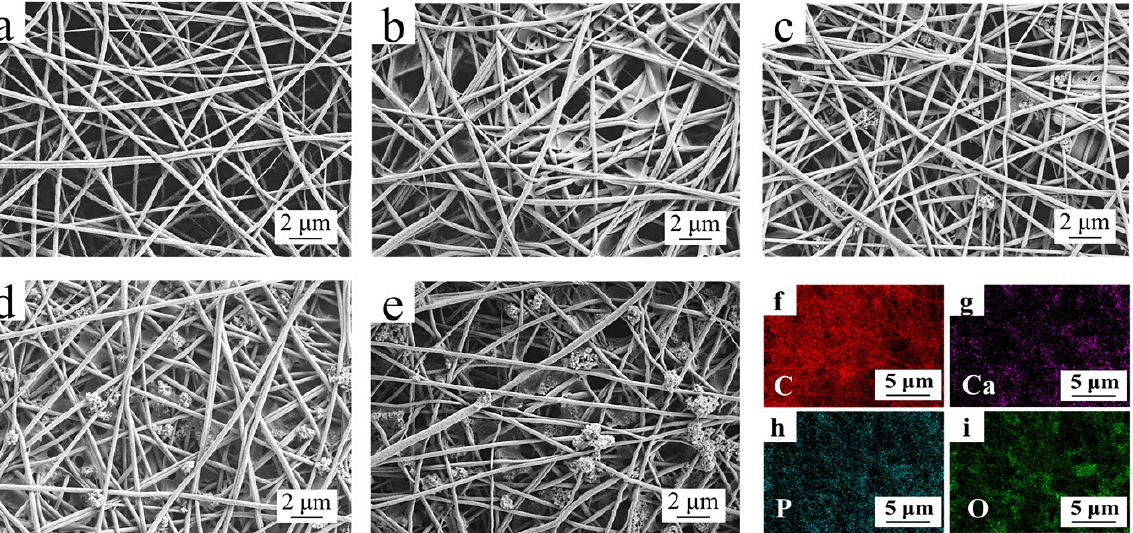
Figure 2. SEM micrographs for the surface of PAN separator and composite separators with different HAP particles concentrations: ( a ) PAN, ( b ) PAN/CA/HAP-0, ( c ) PAN/CA/HAP-0.5, ( d ) PAN/CA/HAP-1.0, ( e ) PAN/CA/HAP-1.5. ( f – i ) Elemental mapping of PAN/CA/HAP-1.0 composite separator.